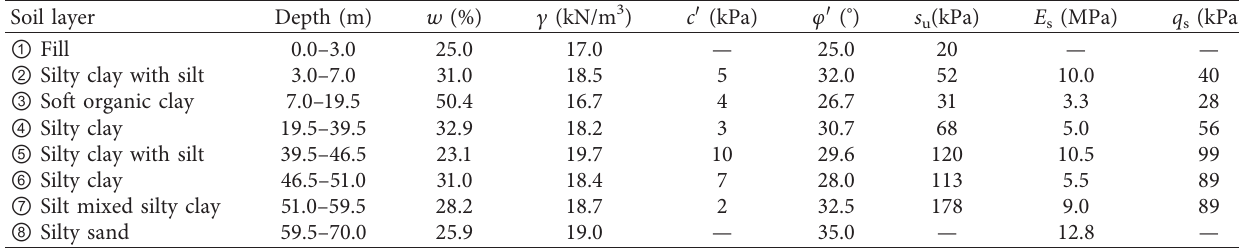
Table 1: Summary of soil